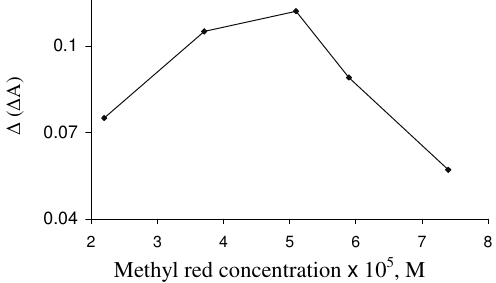
Figure 4. Effect of methyl red concentration on the analytical signal. Conditions: HCl 0.06 M, BrO 3- 2 × 10 -4 M; CTAB 2.6 × 10 -3 M; phenylhydrazine, 0.1 µ g/mL; temperature 27